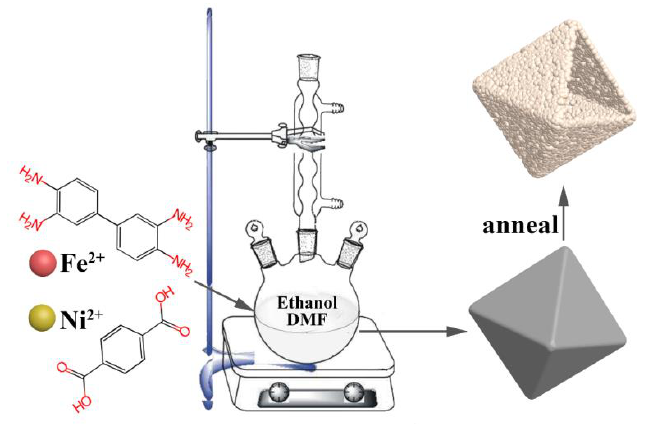
Figure 1. Schematic illustration of the fabrication of the NiFe 2 O 4 nano-octahedrons.